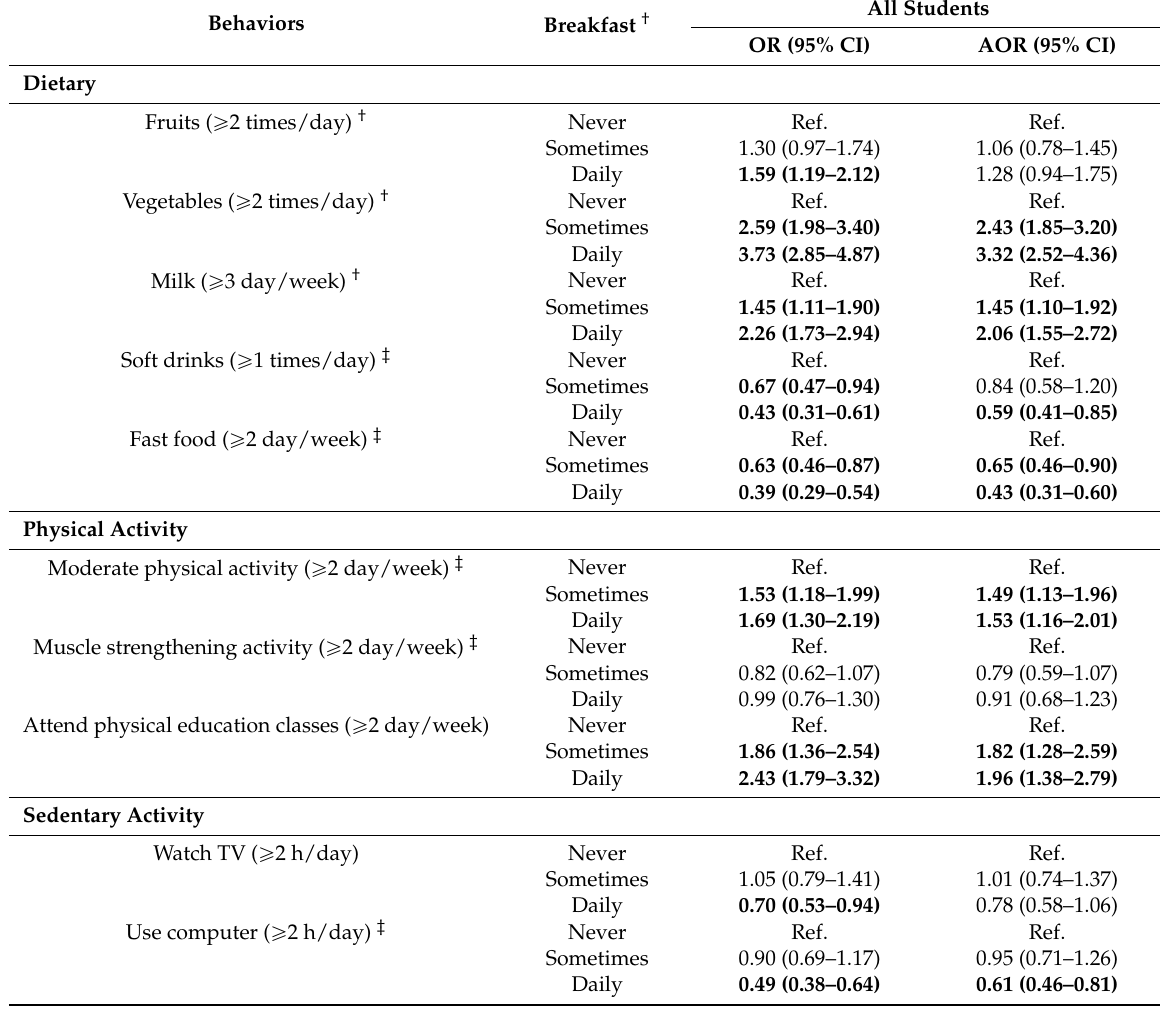
Table 3. Breakfast consumption and its associations with health-related behaviors among all